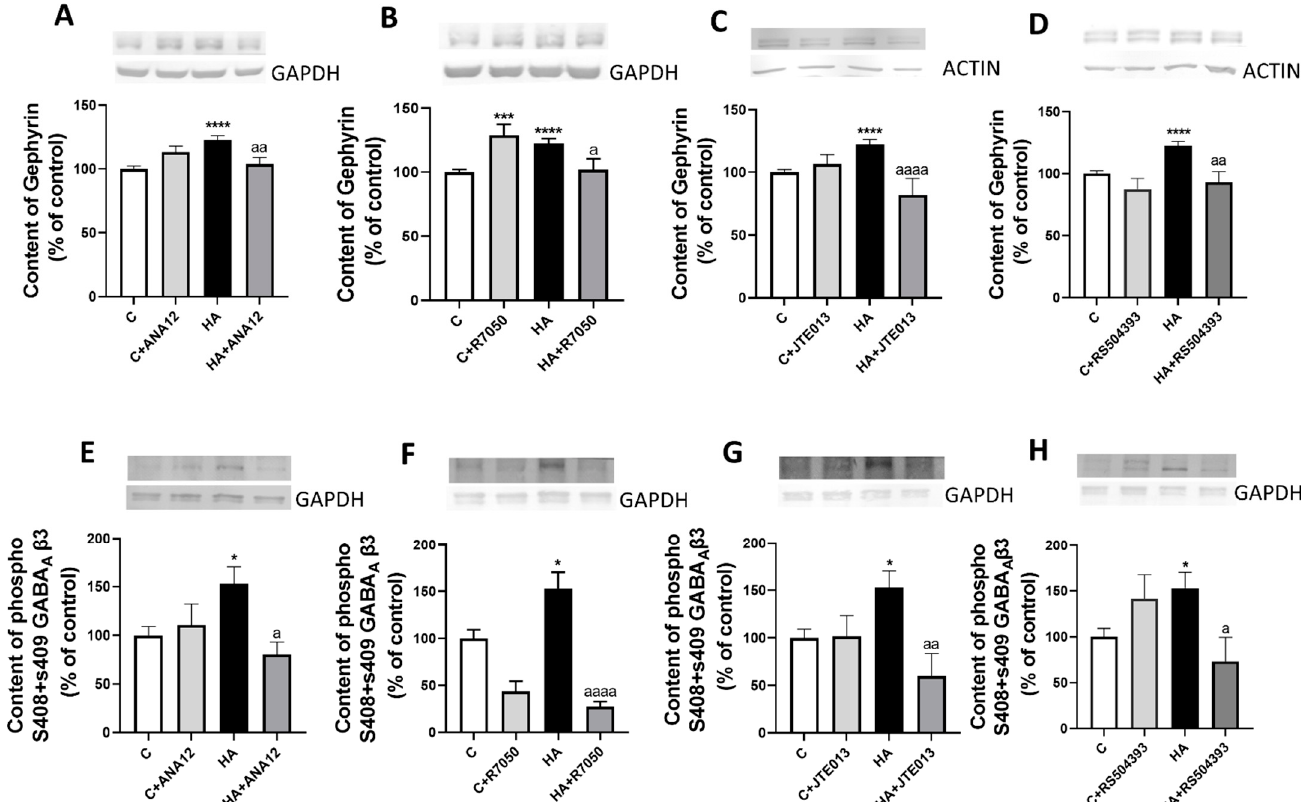
Figure 9. Hyperammonemia increases the content of gephyrin and the phosphorylation of the β 3 subunit of the GABAA receptor in the cerebellum. This is reversed by blocking TrkB, TNFR1, S1PR2 or CCR2. ( A – D ) Gephyrin content and ( E – H ) the phosphorylation of the β 3 subunit of the GABAA receptor in the cerebellum of control (C) and hyperammonemic (HA) rats were analyzed with Western blot. The effects of blocking TrkB with ANA12, TNFR1 with R7050, S1PR2 with JTE-013, or CCR2 with RS504393 on the content are also shown. Values are the mean ± SEM of 15–20 rats per group. Values significantly different from control rats are indicated with asterisks, and from hyperammonemic rats are indicated with “a”. * p < 0.05, *** p < 0.001, **** p < 0.0001; a p < 0.05, aa p < 0.01, aaaa p < 0.0001. ( A – H ) F values were 10.13, 12.54, 13.19, 14.37, 4.059, 12.25, 4.927, and 4.183, respectively.